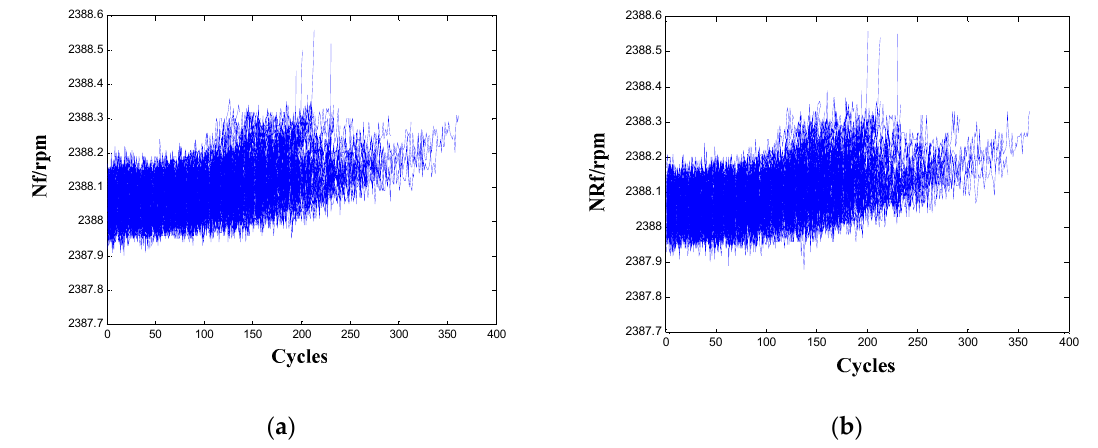
Figure 2. Sensor signals for the 100 training engines: ( a ) Nf; ( b ) NRf.